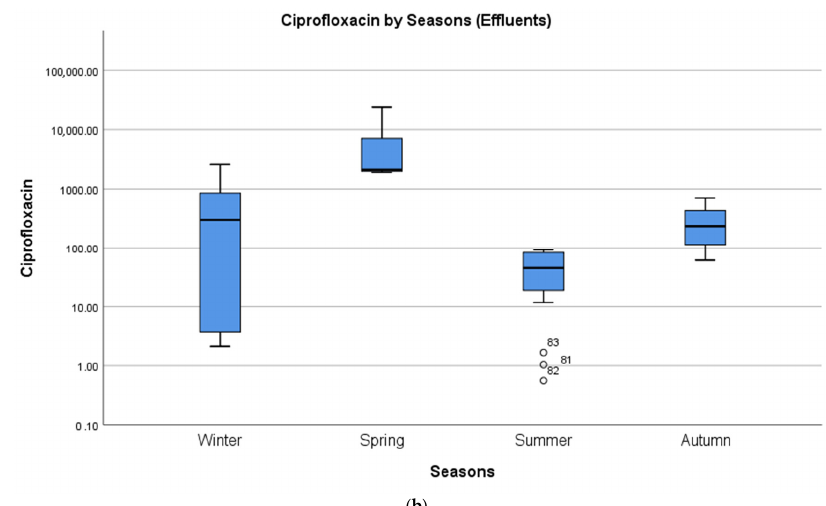
Figure 6. Seasonal differences in azithromycin ( a ) and ciprofloxacin ( b ) concentrations in effluent WW (values in ng/L are reported on a log10 scale). Asterisks indicate that comparisons between means were not performed for azithromycin concentrations in spring and autumn because the two groups had fewer than two cases (WWTPs). Results of one-way ANOVA and the independent t -test are illustrated in the supplementary material (Tables S8–S11).